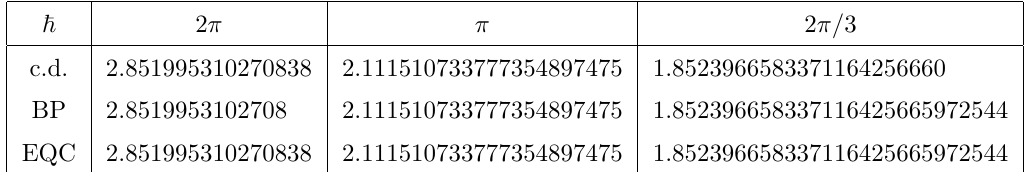
= (cid:25) i = 2 and three di(cid:11)erent 0